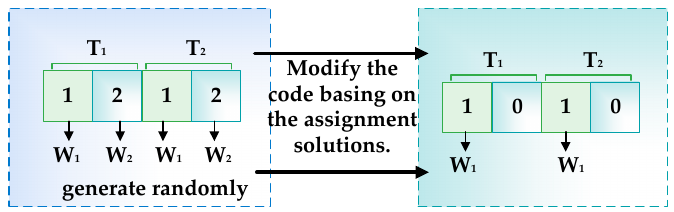
Figure 8. Lower-level algorithm coding schematic.